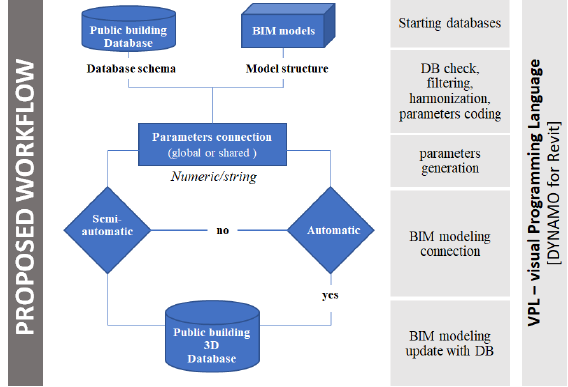
Figure 4. The synthetic proposed data flowing pipeline applying with VPL: from public DB and BIM models to 3D spatial database